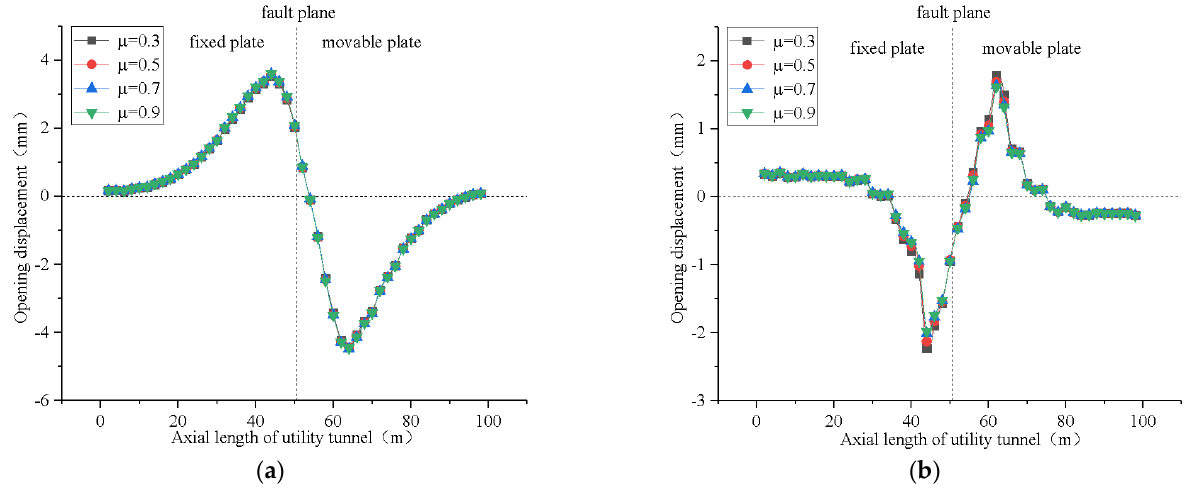
Figure 15. Distribution curve of the longitudinal horizontal opening displacement. ( a ) Roof ( b ) Floor.